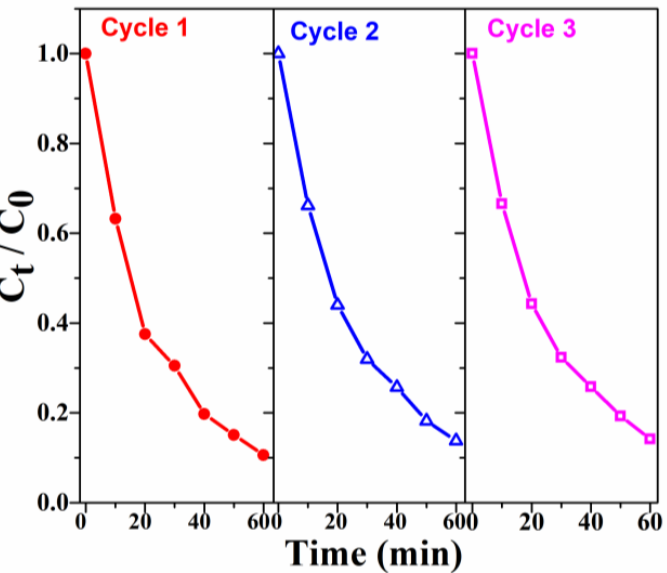
Figure 8. Cycling test of Co-N-CNTS for the E-Fenton degradation of RhB (initial RhB concentration = 20 mg L −1 ).